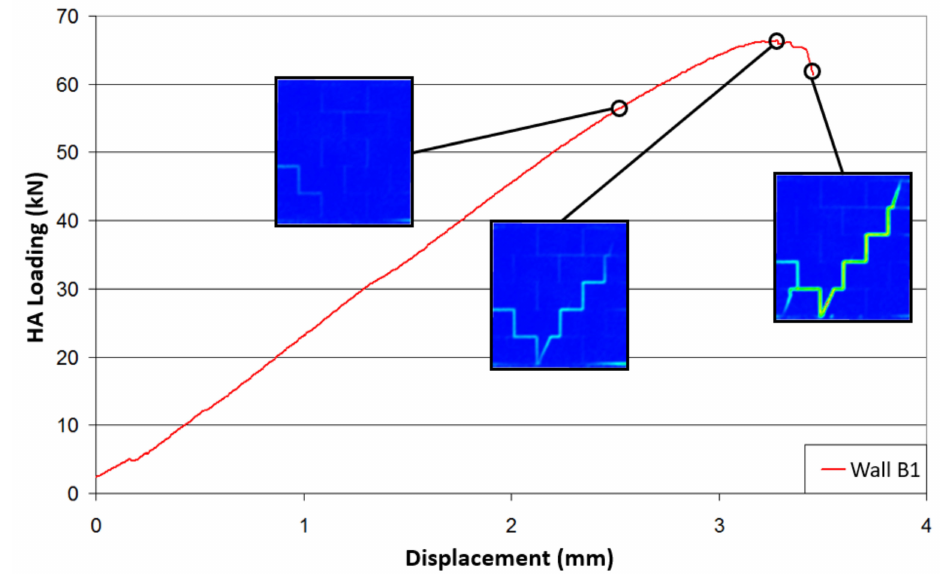
Figure 5. Evolution of cracking during the test of URM wall